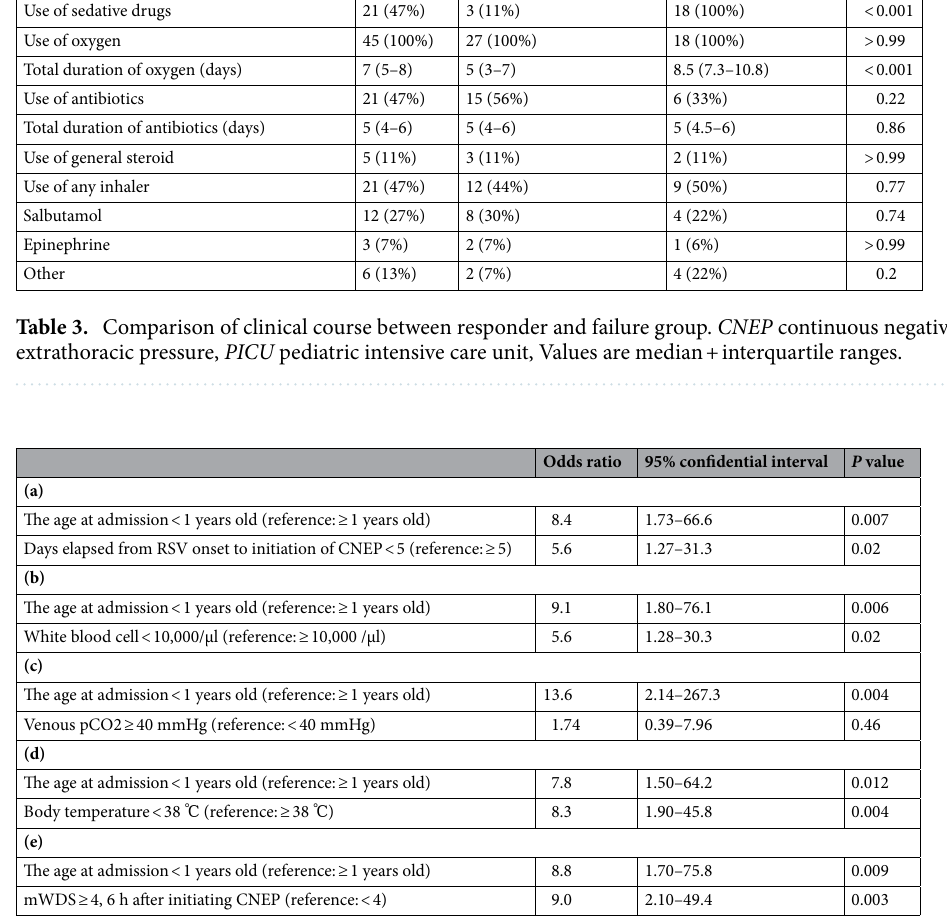
Table 4. Adjusted for variables including age < 1 or ≥ 1 year at admission and (a) less than 5 days elapsed from RSV onset to the initiation of CNEP or more than 5 days, (b) WBC count < 10,000 or ≥ 10,000 /µl, (c) venous blood pCO2 levels ≥ 40 or < 40 mmHg at admission, (d) body temperature < 38 ℃ or ≥ 38 ℃ at admission, (e) mWDS ≥ 4 or < 4, 6 h after initiating